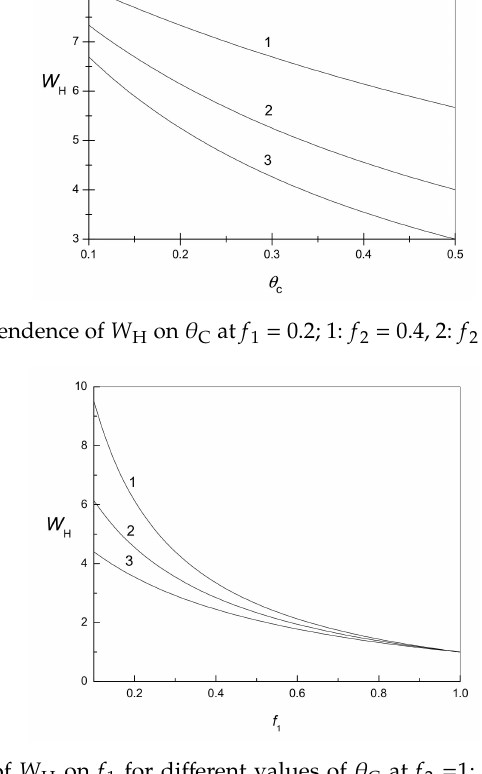
Figure 3. Dependence of W H on f 1 for di ff erent values of θ C at f 2 = 1; 1: θ C = 0.1, 2: θ C = 0.2, 3: θ = C